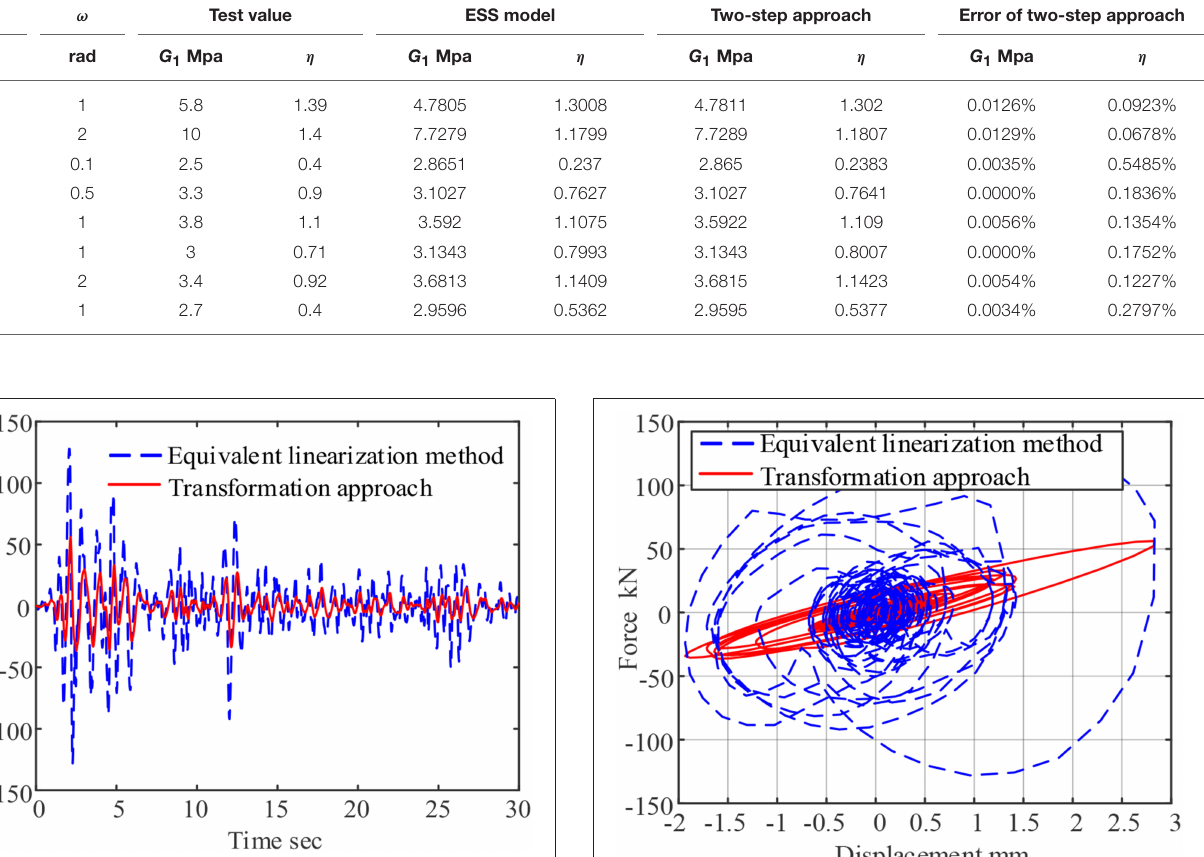
FIGURE 4 | Force-Displacement curve of viscoelastic resistance under seismic load (assuming working frequency is 0.2Hz).